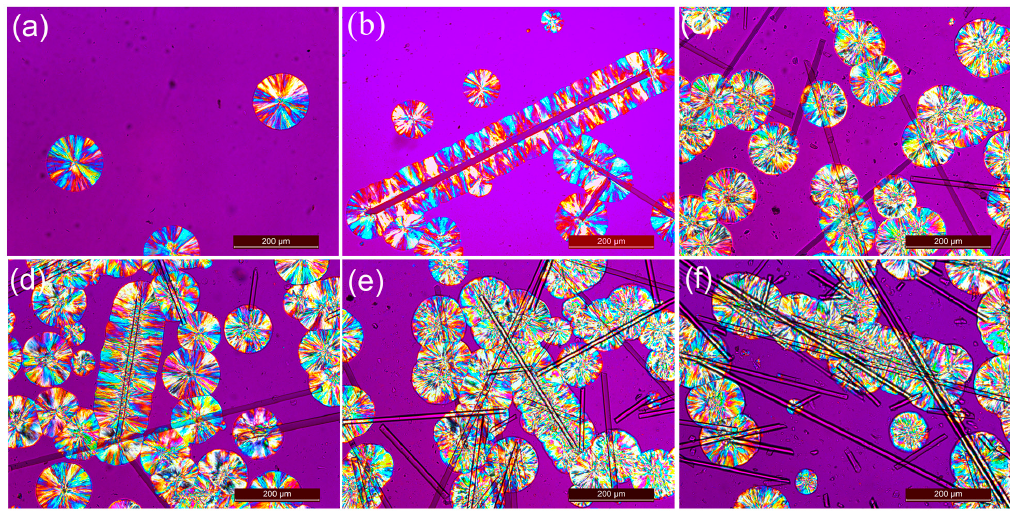
Figure 3. Polarized optical microscope (POM) images of ( a ) PBS, ( b ) PBS/MBF (98/2), ( c ) PBS/BF (95/5),